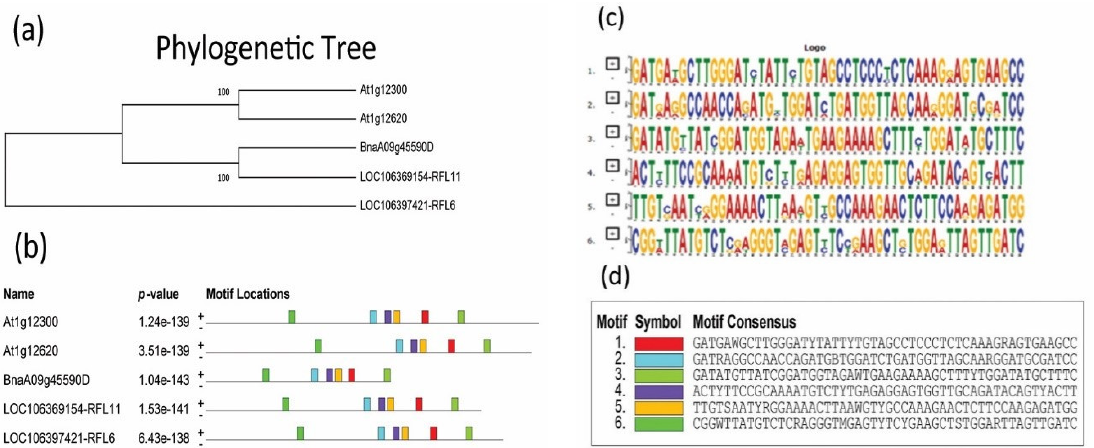
Figure 1. Conserved motif analysis and phylogenetic relationship of BnaRFL11 with other gene species. ( a ) Phylogenetic tree showing an association between BnaRFL11 and its sister genes in Arabidopsis . Protein sequences were obtained from the GenBank with the following gene ID: BnaA09g45590D , AT1G12300 , and AT1G12620. ( b ) Presence of similar motifs between sequences. ( c , d ) The conserved motifs among BnaRFL11, known fertility restore genes Rfn and Rfp , and Arabidopsis thaliana sister genes.